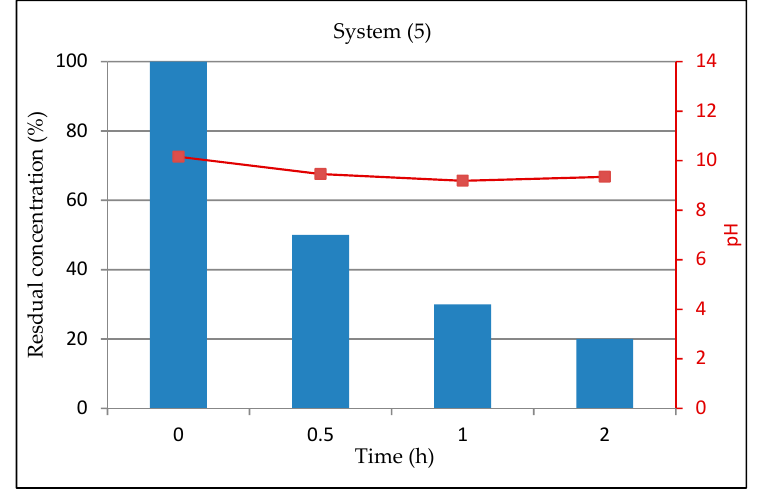
Figure 13. Residual concentration (%) and pH for System 5, as a function of the UV irradiation time exposure.